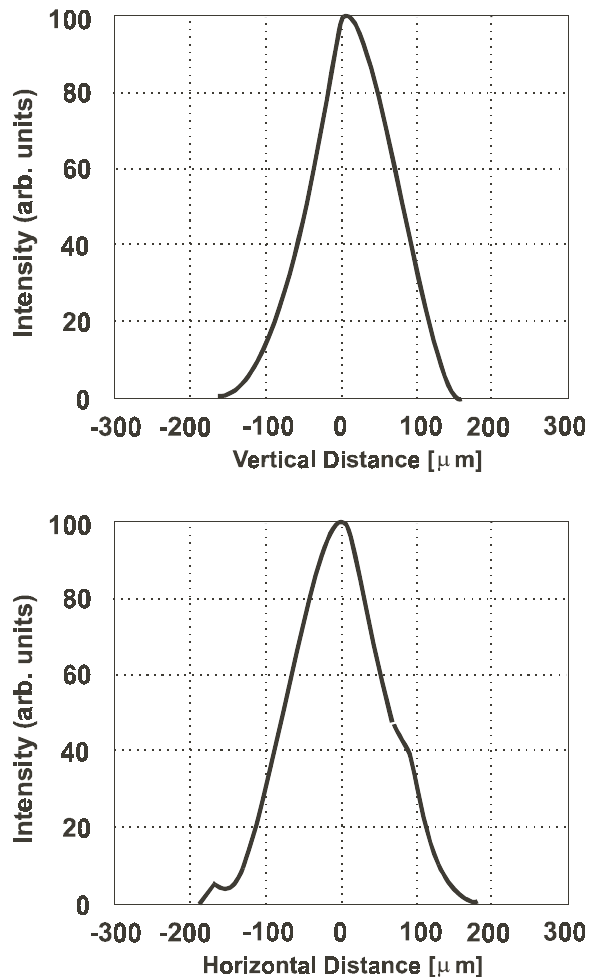
FIG. 3. Luminescence intensity profiles produced by the e beam on the phosphor screen.